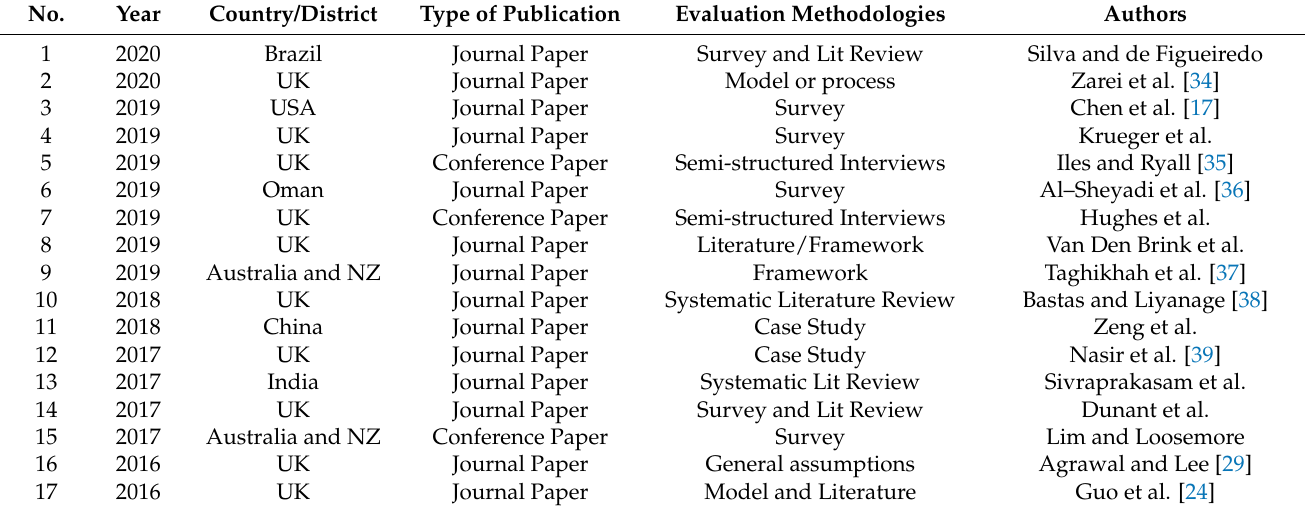
Table 1. Classification of the responsible sourcing publications used in this